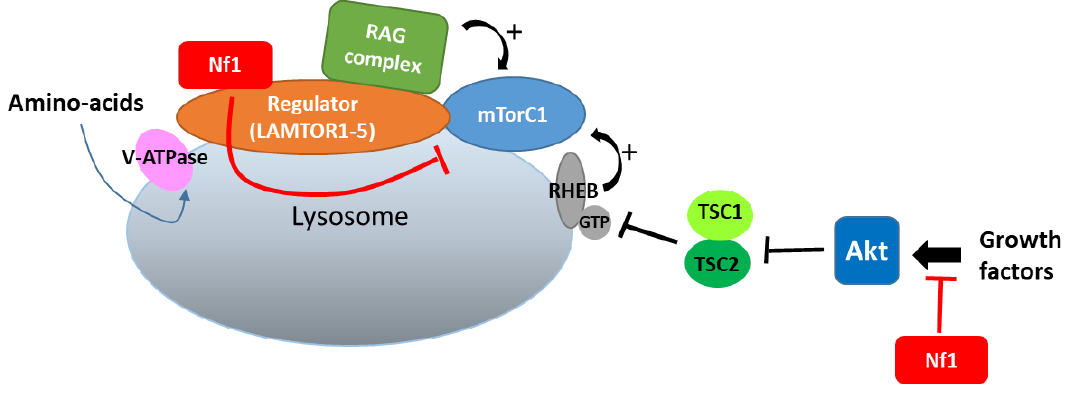
Figure 11. Neurofibromin binds to LAMTOR1 and inhibits mTORC1 signaling.